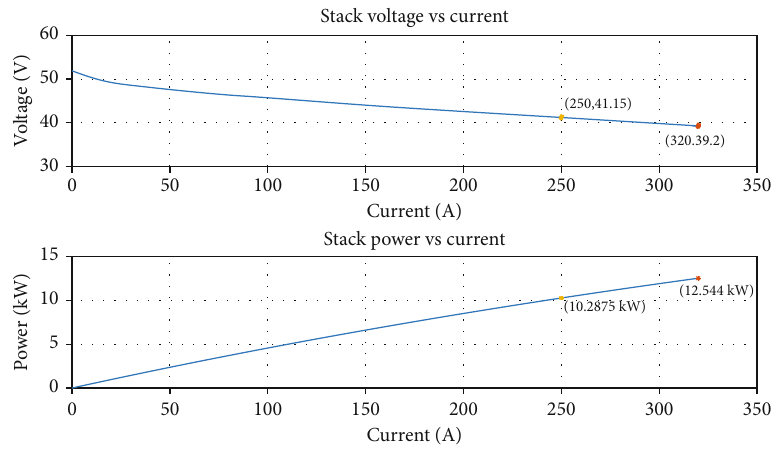
Figure 4: The dynamic behaviour of PEMFC.